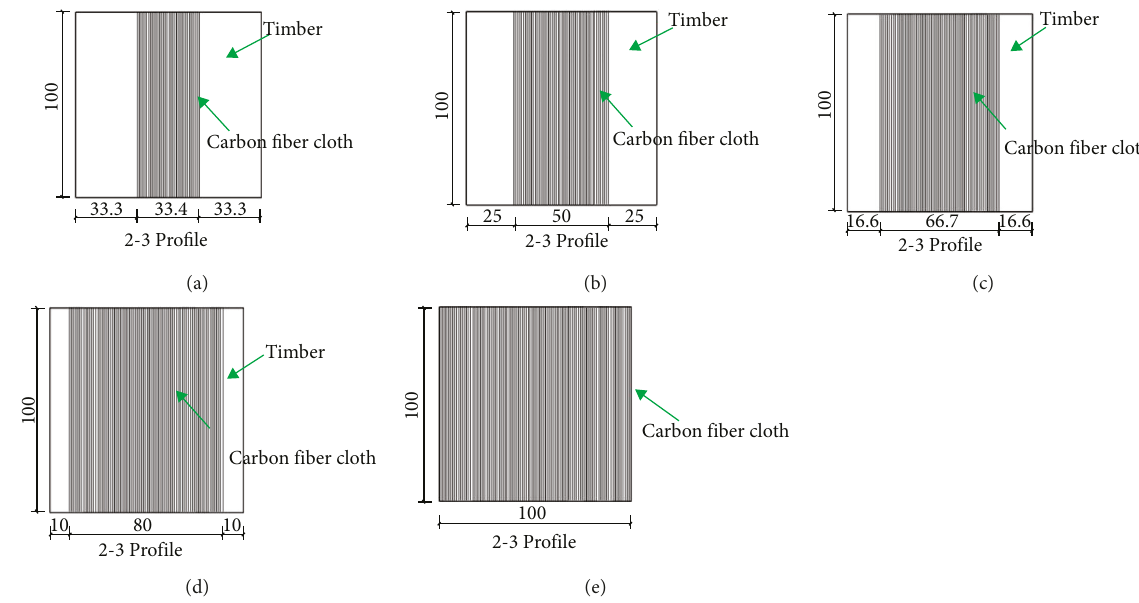
Figure 2: Different carbon fiber ratios: (a) A 1, (b) A 2, (c) A 3, (d) A 4, and (e) A